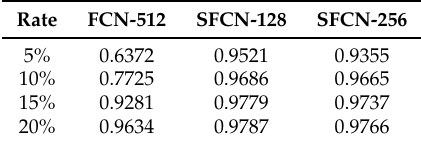
Figure 8. The architecture of FCN-512, where Image represents the input image (no sliding window operation), Conv represents the convolutional layer, Pool represents the max pooling layer, Deconv represents the deconvolutional layer, three color (including white, blue and black) arrows represent the convolution, max pooling, and deconvolution operation, respectively; add “+” represents the add operation. In addition, the size of each layer is also given. Table 5. Classification Results of Xi’an with FCN-512 and SFCN as a function of the rate of training